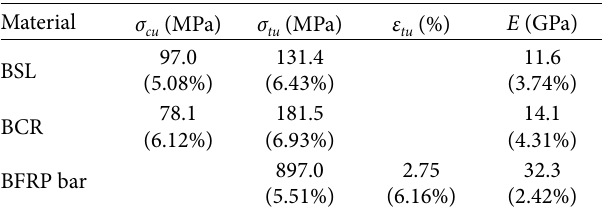
Table 1: Material properties of bamboo engineering materials and BFRP bar.